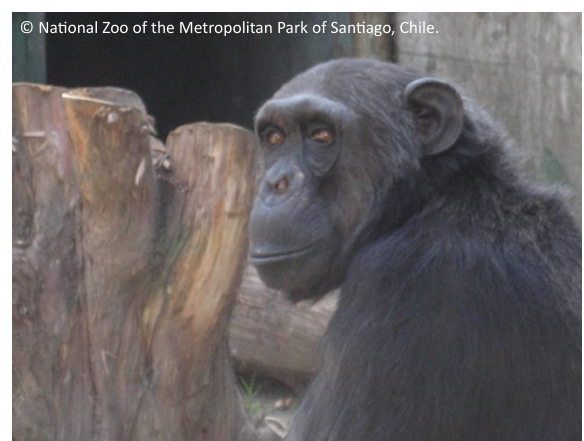
Image 1. Specimen 1 - Pan troglodyte s schweinfurthii